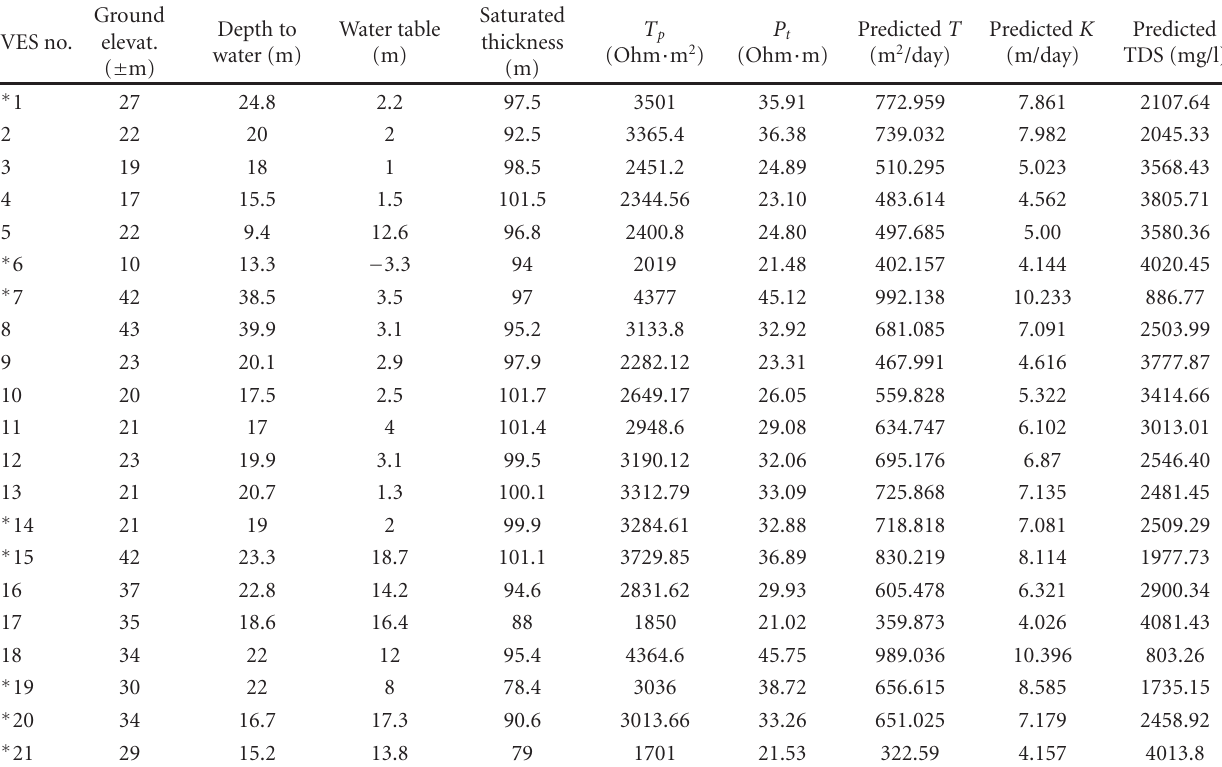
Table 3: Geoelectrical parameters and predicted transmissivity, hydraulic conductivity, and salinity of the Quaternary aquifer from the Vertical Electrical Soundings (VESs). VES no.